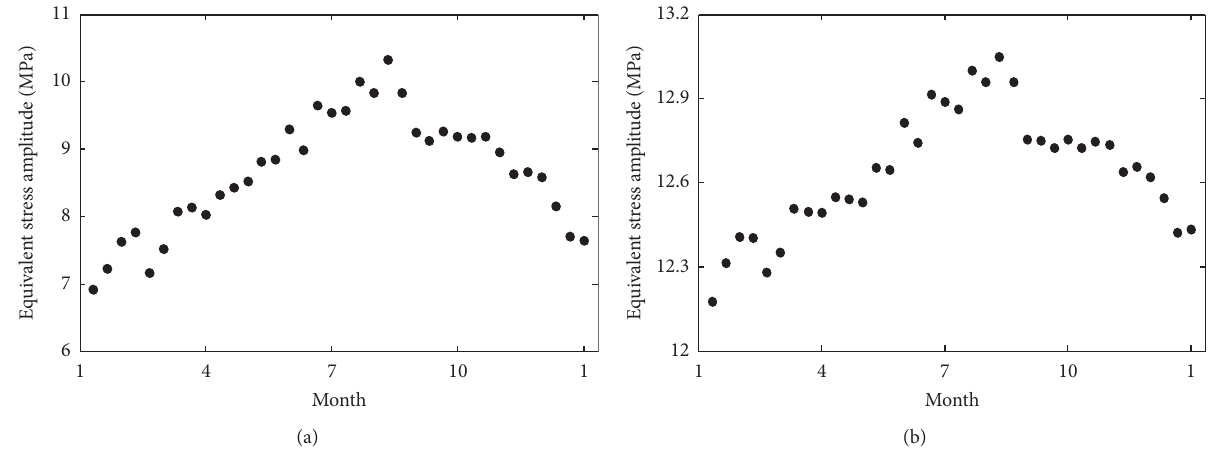
Figure 11: The scattered diagrams of S eq : (a) the rib-to-deck joint and (b) the rib-to-rib joint.